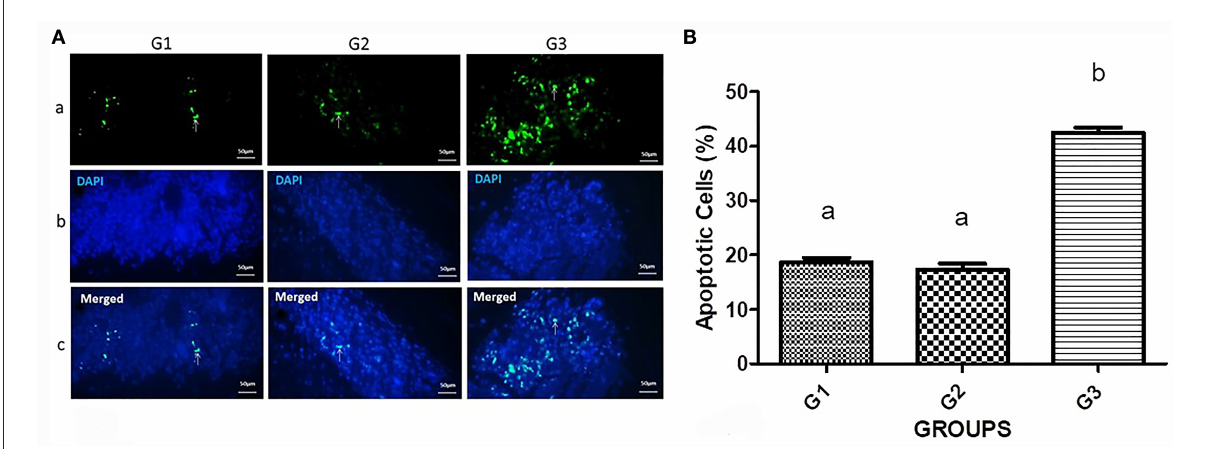
FIGURE4 Apoptosis induction in the bipSUR treated mice. (A) Apoptotic cells are demonstrated with fluorescent green nuclei in a dark field (arrows). The tumor sections of bipSUR treated mice (G3) showed a higher number of apoptotic cells than G1 and G2. Panel b and c reveal the stained cells with DAPI dye and the merged figures in the same fields. (B) Quantification of apoptosis ratio. Apoptosis has significantly occurred in tumor tissues in response to the bipSUR. Different letters (a and b) demonstrate significant differences among groups at P <